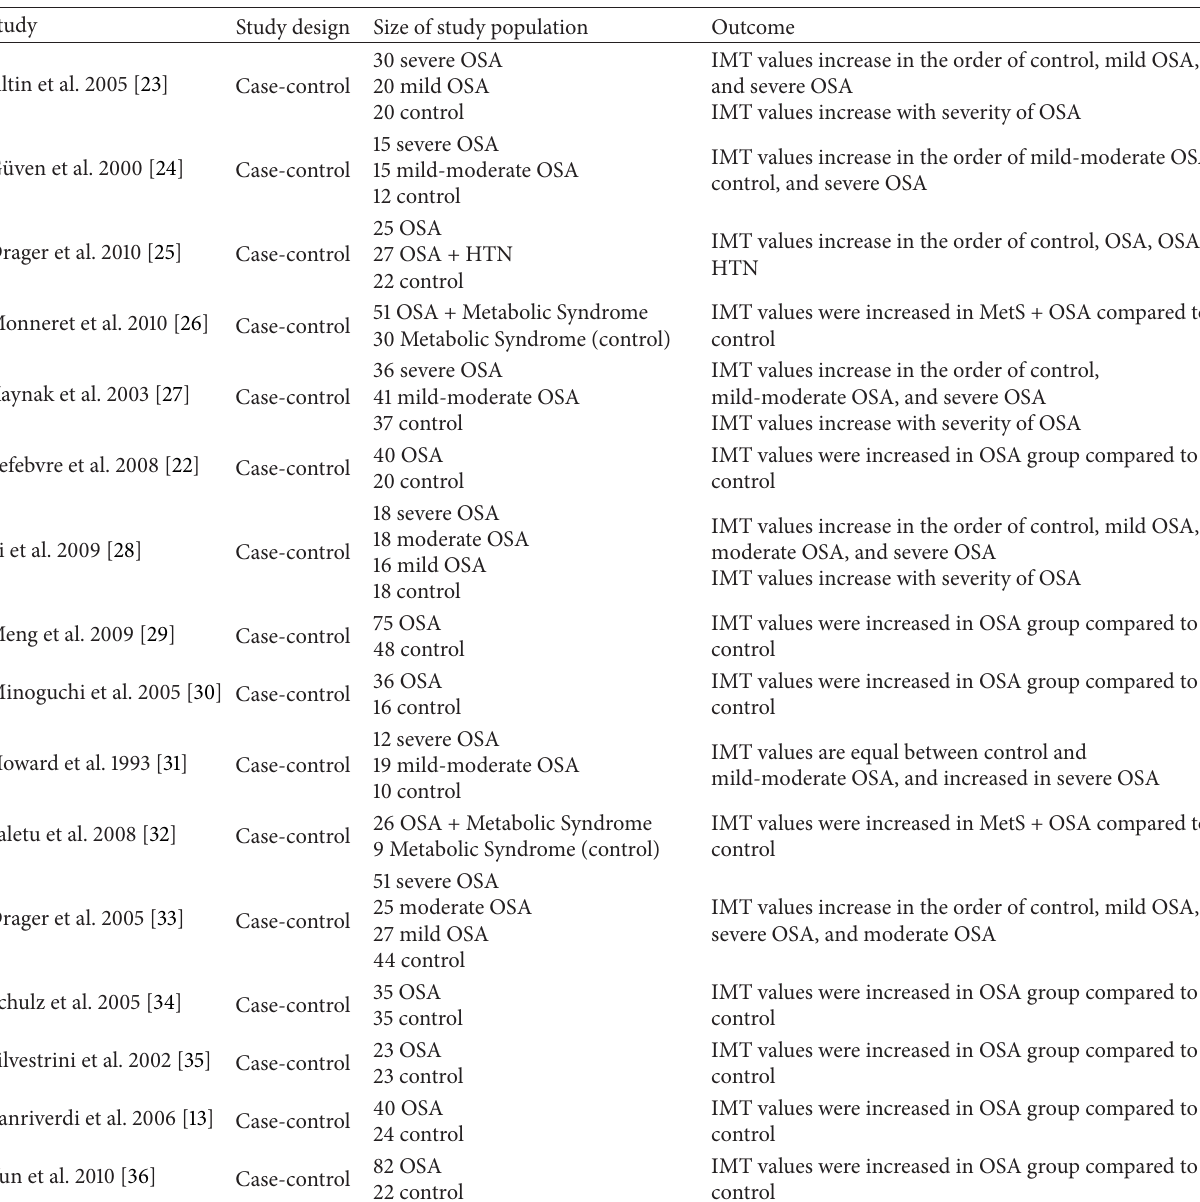
Table 1: Included studies assessing CIMT thickness in adult OSA patients versus